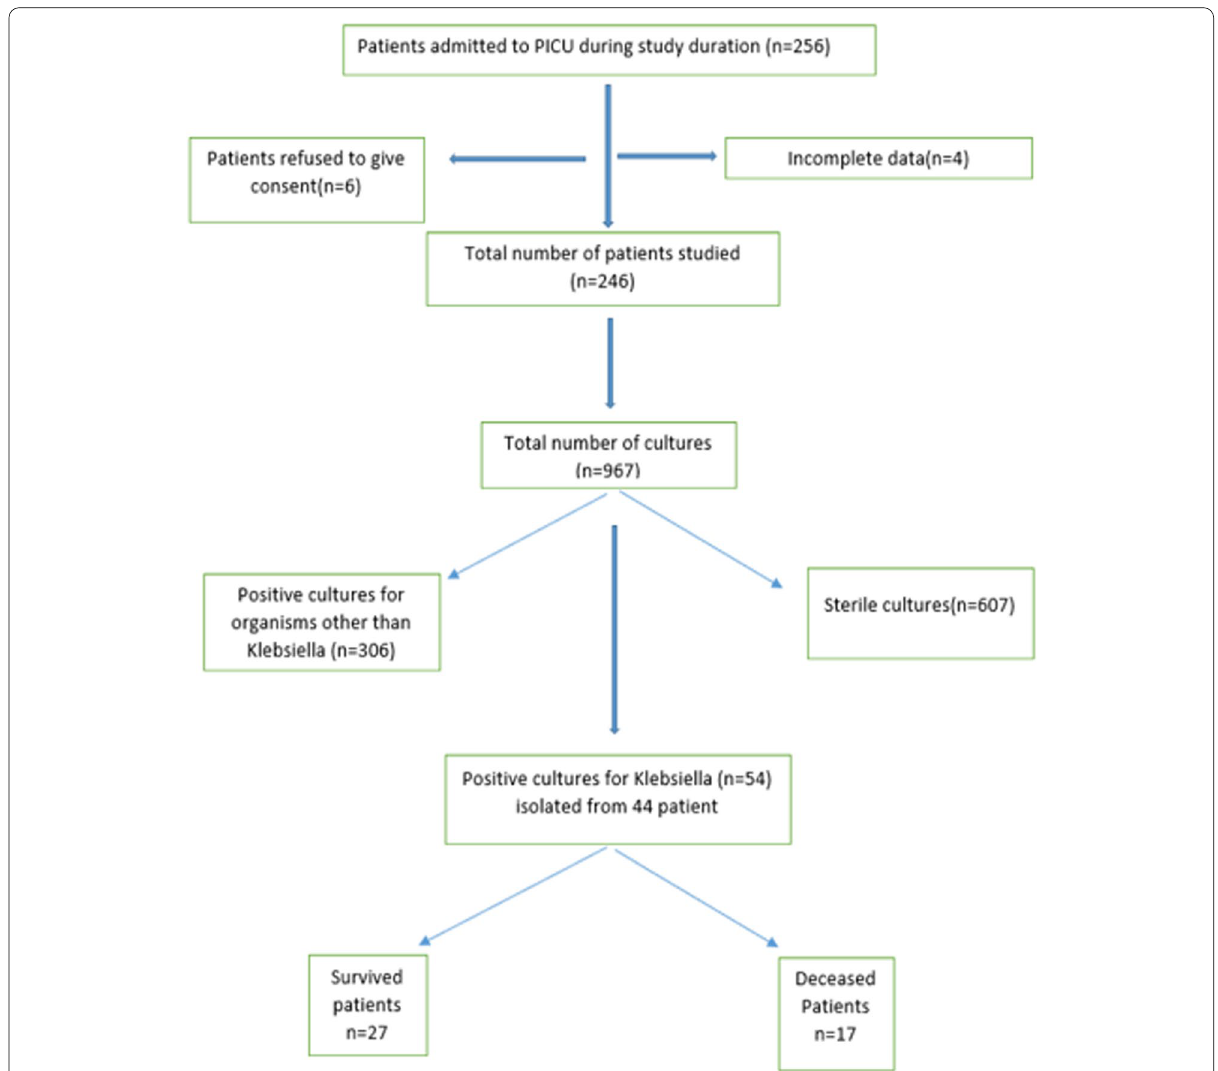
Fig. 1 RECORD strategy of the recruitment of the studied